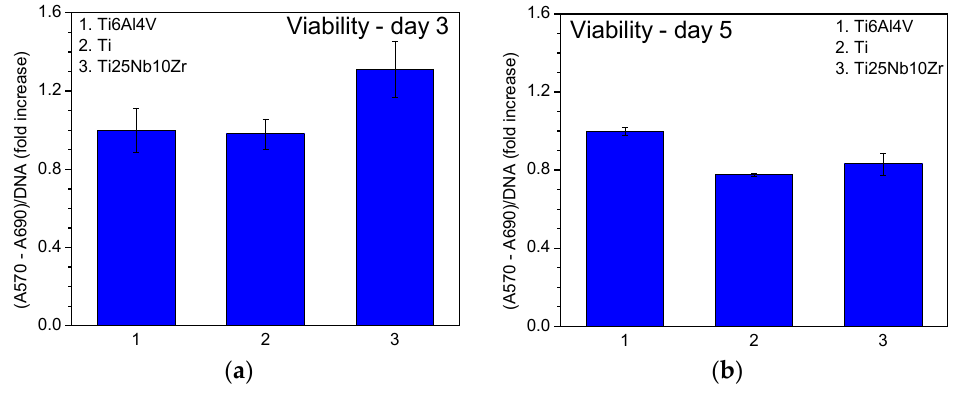
Figure 9. Cell viability of the samples measured after 3 ( a ) and 5 ( b ) days of culture.